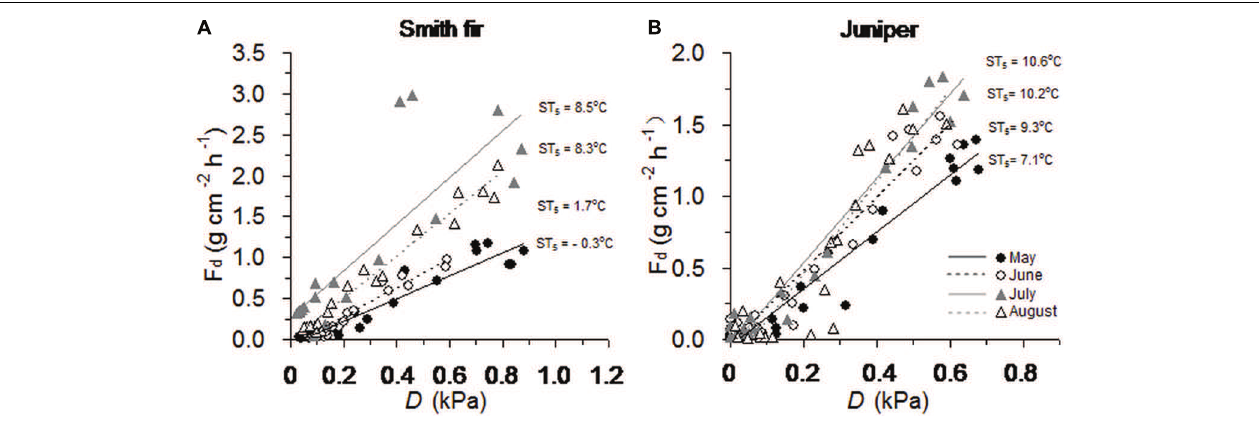
FIGURE 3 | Relationships between hourly sap flow density ( F d ) and vapor pressure deficit ( D ) on bright days over growing-season months across (A) Smith fir and (B) juniper trees. Note that mean soil temperature at 5 cm (ST 5 ) range from − 0.3 to 8.5 ◦ C and from 7.1 to 10.6 ◦ C for Smith fir and juniper trees,